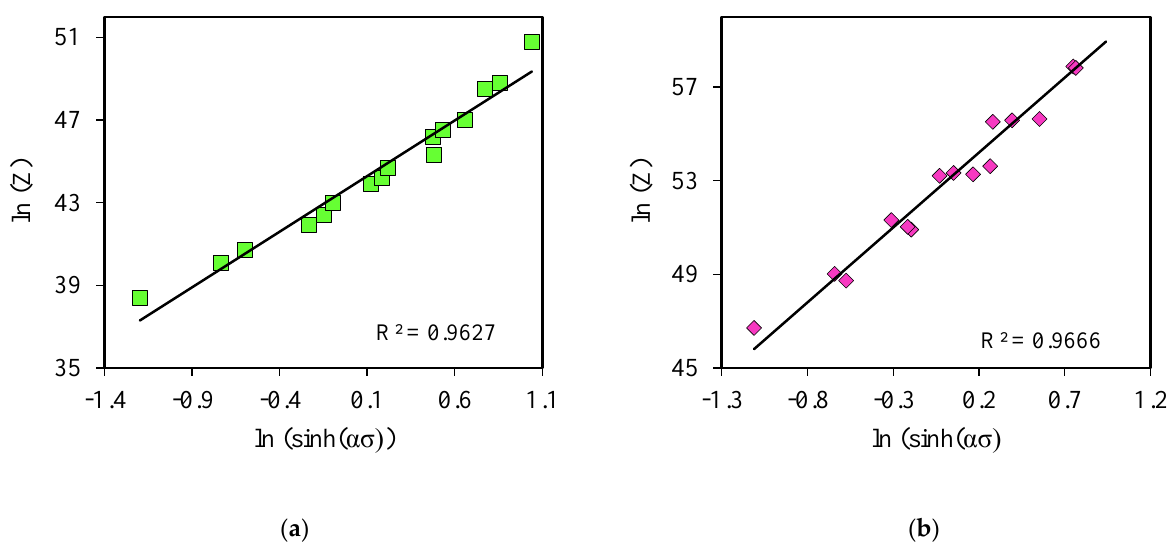
Figure 9. Plots of ln (Z) vs. ln (sinh(ασ)) for ( a ) steel A and ( b ) for steel B . The calculated material constants for steel A and steel B for the constitutive equations are given in Table 2. Table 2. Material constants and activation energy for steel A and steel B. P91